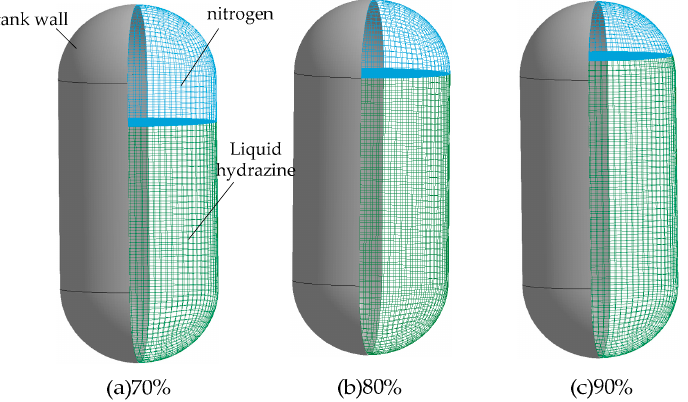
Figure 10. Simulation models of the satellite tanks with liquid-filling ratios of 70%, 80%, and 90%.